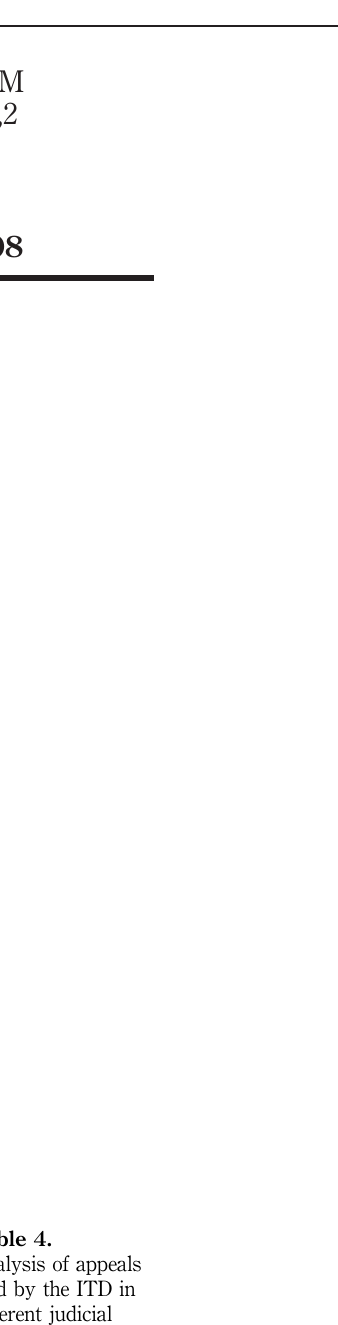
Table 4. Analysis of appeals filed by the ITD in different judicial